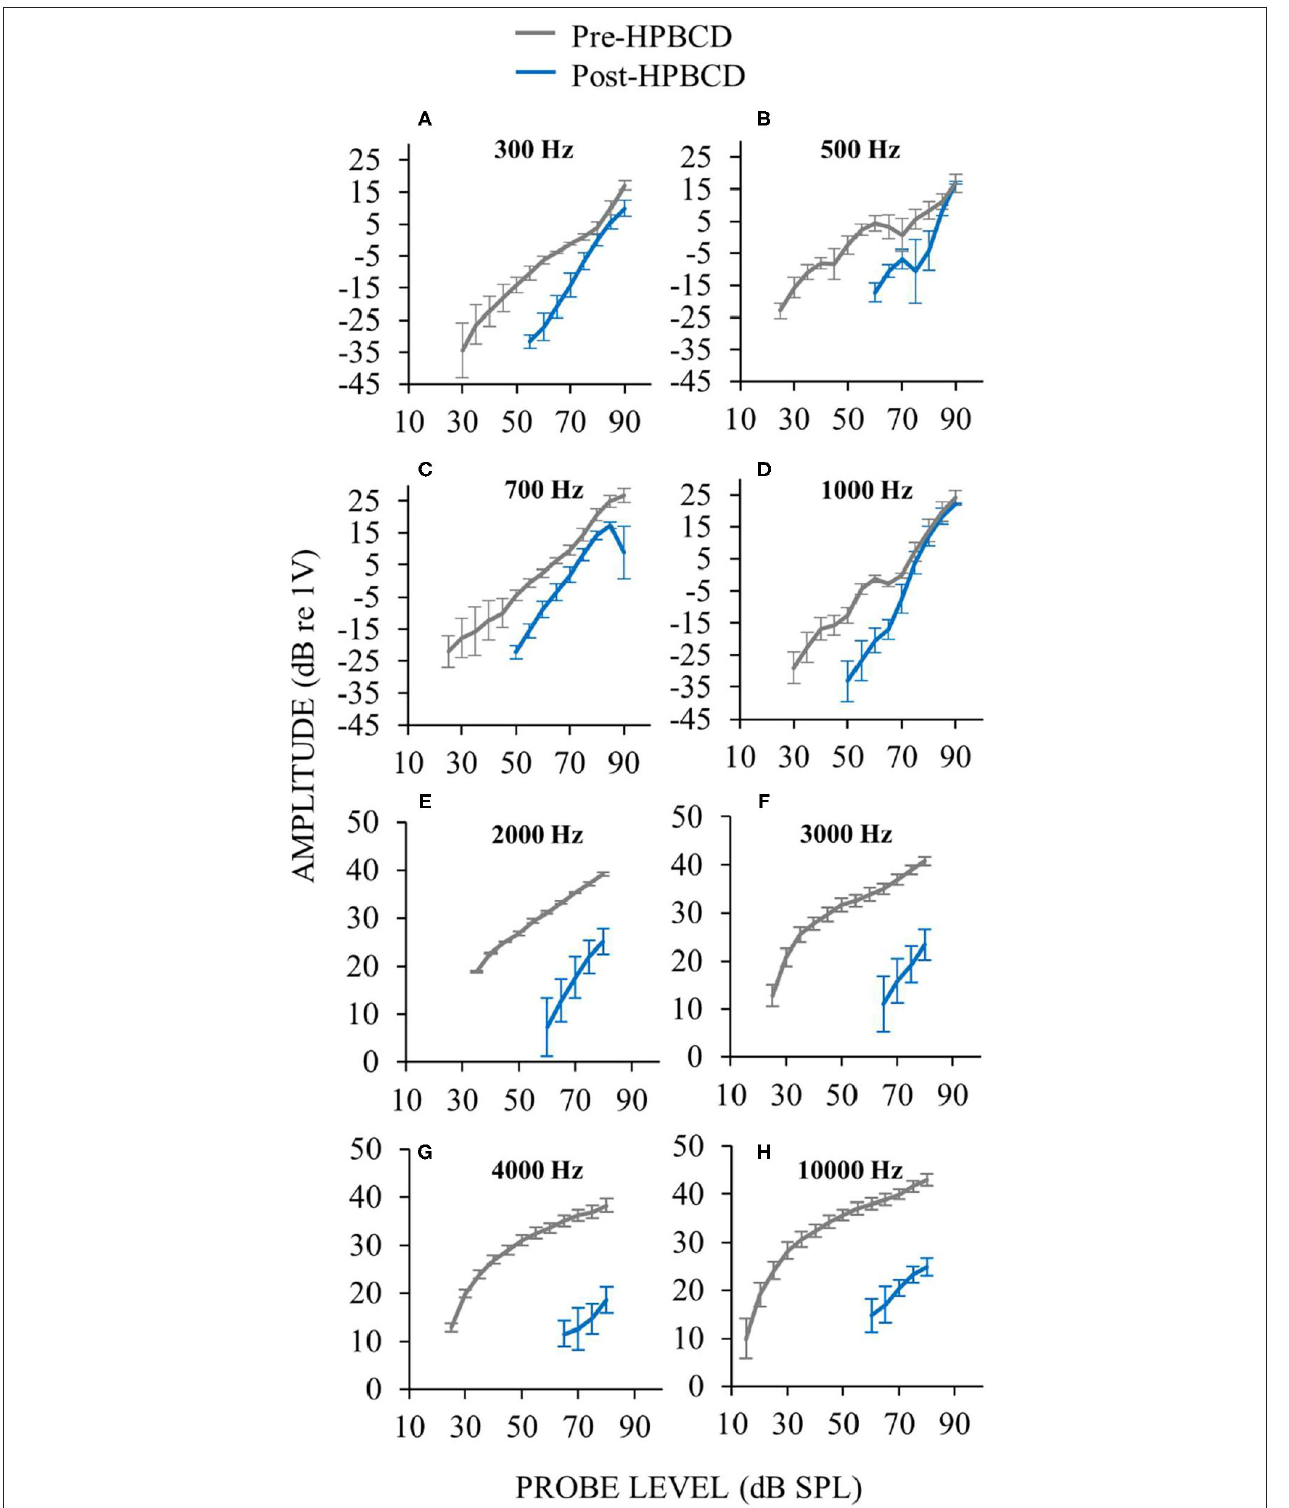
FIGURE 9 | Auditory-nerve responses over a wide range of frequencies and sound level before (gray) and after (blue) cochlear perfusion with 13mM HPBCD. ANOW was used at low frequencies 300 Hz (A) , 500 Hz (B) , 700 Hz (C) , 1,000 Hz (D) , CAPs were used for mid and high frequencies 2,000 Hz (E) , 3,000 Hz (F) , and 4,000 Hz (G) . Only one exemplar high frequency plot is shown (10 kHz, H ) because plots from all high frequencies were similar. Data are averages from three ears. Error bars are one standard error of the mean. Response recruitment was seen only at low frequencies.